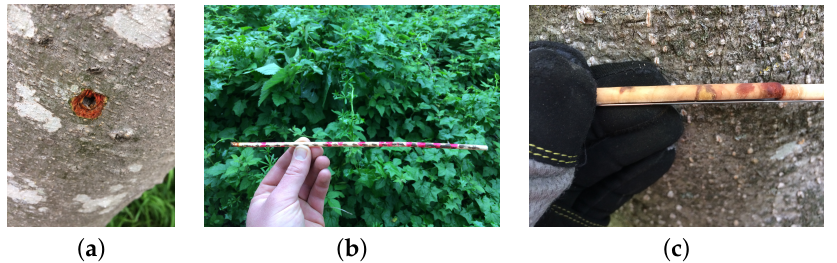
Figure 4. Core sampling to measure of sap wood and heartwood depth. ( a ) tree bore after core retrieval, ( b ) retrieved tree core, and ( c ) a close-up of the core showing sap wood to heartwood transition. The sapwood depth, D sap , of phreatophytic trees in each plot was measured in only a subset of the trees on the plot. Here, we outline the approach used to estimate D sap ,